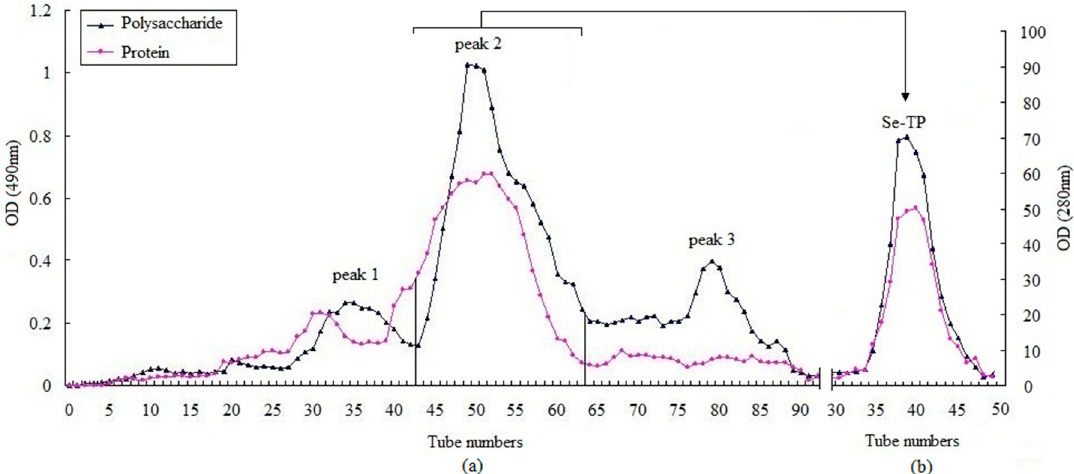
Figure 2. Separation and purification of Se-TP: ( a ) separation of the crude polysaccharides using a DEAE-52 cellulose column, and ( b ) purification of sample using a Sephadex G-150 column.